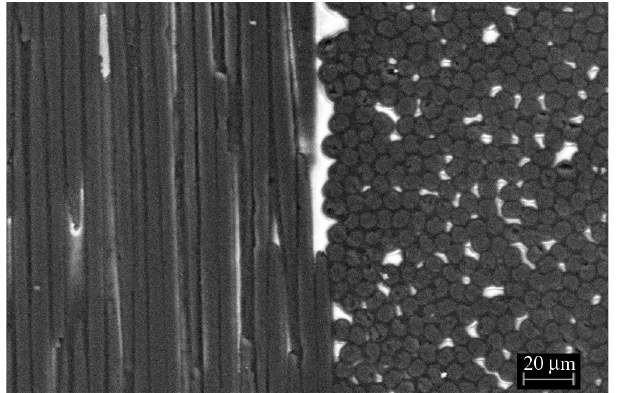
Figure 7. Micrograph of interface region of dry carbon/BMI fabric laminate.